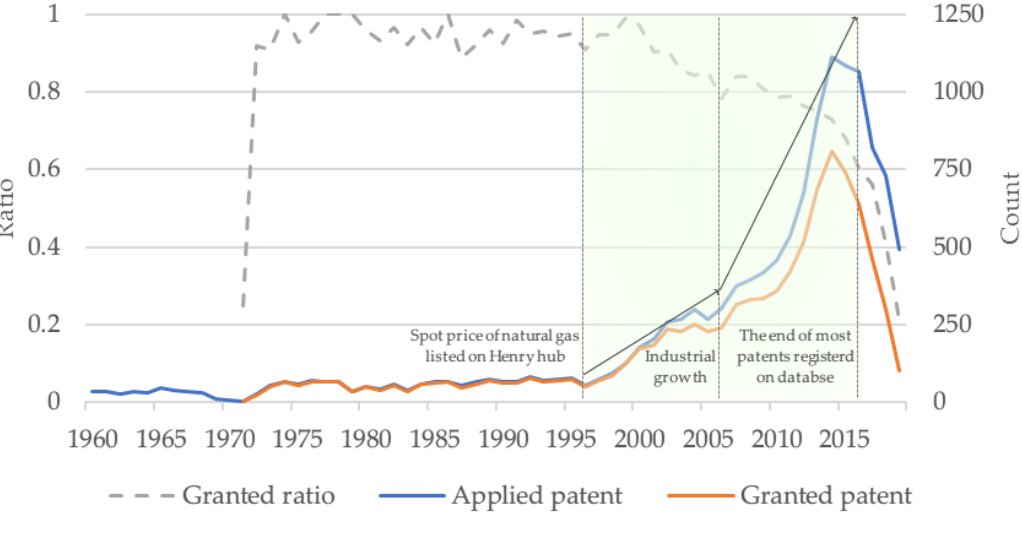
Figure 1. Annual patent count for the whole dataset—1967 to 2019 [27].